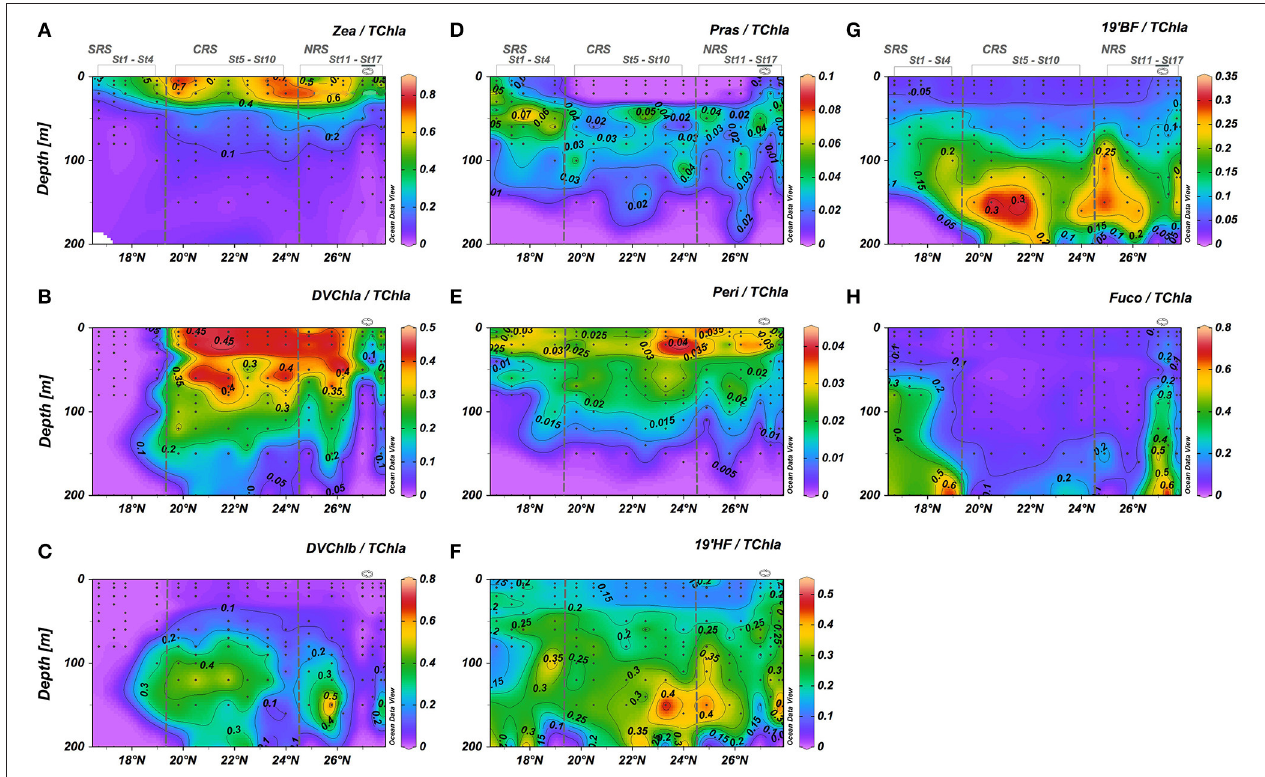
FIGURE 7 | Cross sections for pigment concentrations normalized to Total chlorophyll-a across the south-north transect. (A) Zeaxanthin/TChl-a; (B) Divinyl Chlorophyll-a/TChl-a; (C) Divinyl Chlorophyll-b/TChla; (D) Pasinoxanthin/TChla; (E) Peridinin/TChla; (F) 19 ′ Hexanoyloxyfucoxanthin/ TChl-a; (G) 19 ′ Butanoyloxyfucoxanthin/TChl-a; (H) Fucoxanthin/TChl-a. Black dots represent sampling points. Eddy stations marked along the top of the upper